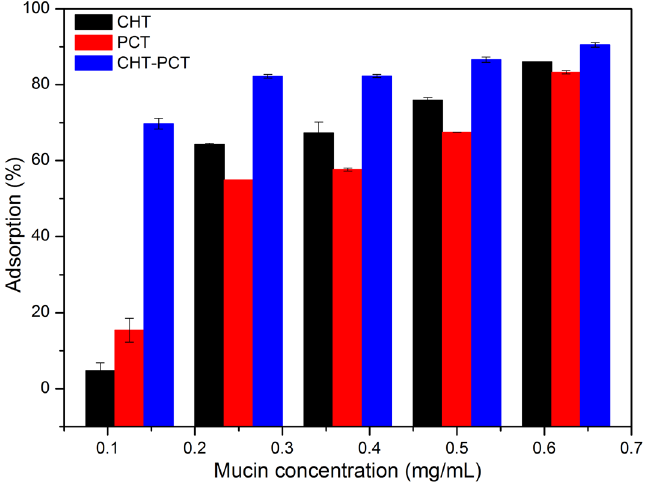
Figure 1. In vitro mucin mucoadhesion test with chitosan (CHT), pectin (PCT) and polyelectrolyte complex (CHT–PCT) matrices. Data are mean ± S.D., n = 3.